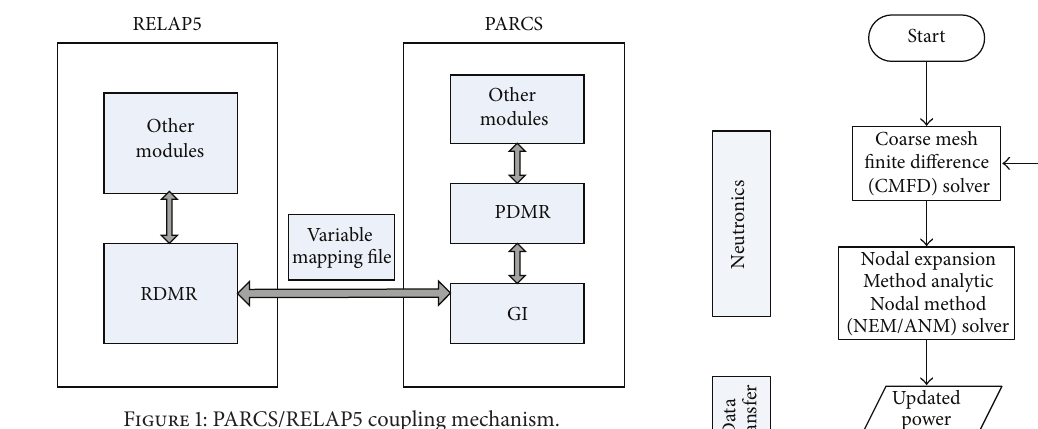
Figure 1: PARCS/RELAP5 coupling mechanism.